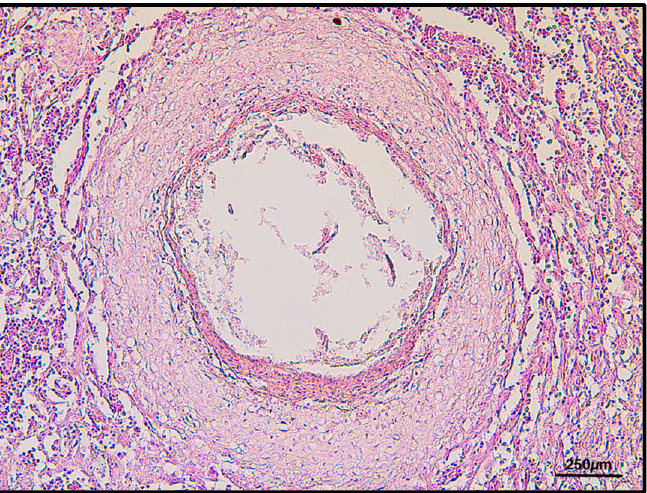
Figure 5. Thick granuloma reaction without parasites inside, H&E10×. Molecular Identification of Anisakis spp.